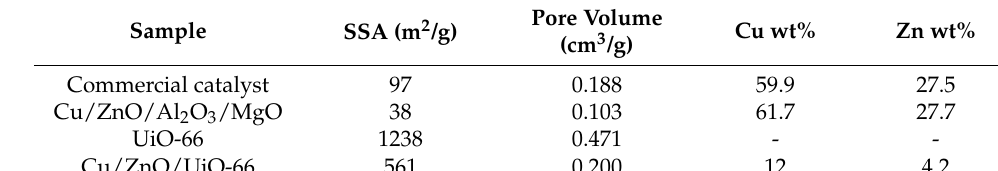
Table 1. Specific surface area, pore volume, and elemental loading of prepared materials.